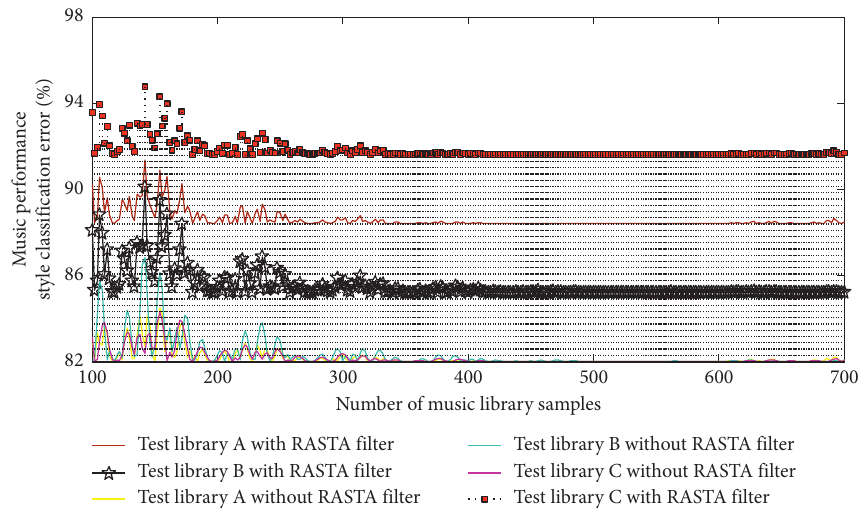
Figure 8: Comparison of PLP parameters processed by RASTA